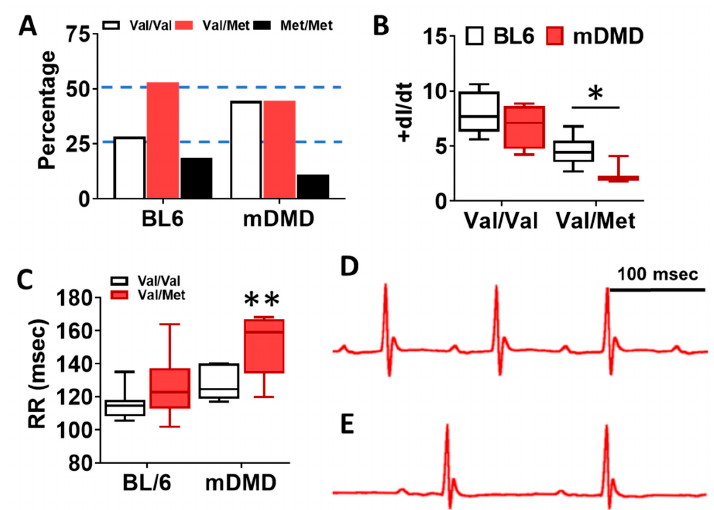
Figure 5. Dystrophic mice have altered distribution of rs6265 polymorphisms, altered cardiomyocyte contractility, and bradycardia. ( A ) Plot showing genotypic distribution of offspring from Val/Met breeding pairs on a normal C57BL/6 (BL6) or mdx/mTR dystrophic (mDMD) background. Percentage of offspring for each of the three possible genotypes are shown on the y axis, with the expected Mendelian ratio of 1:2:1 (or 25%, 50%, 25%) indicated by dashed lines. Val/Val (white), Val/Met (red), and Met/Met (black). ( B ) Box and whisker plot showing peak fractional shortening as the change in the length over time (+dl/dt) of cardiomyocytes isolated from Val/Val or Val/Met mice on a BL6 ( n = 10, n = 14) or mDMD ( n = 4, n = 3) background. ( C ) Plot showing the RR interval as measured by electrocardiography of Val/Val (white) and Val/Met (red) mice on the C57BL/6 (BL6, n = 8, 18) or mdx/mTR (mDMD, n = 6, 3) background. Example electrocardiograms are also shown for Val/Val ( D ) and Val/Met ( E ) mice on the mDMD background. * Asterisk represents statistical significance (* p = 0.0282, Student’s t -test, p = 0.0032, two-way ANOVA), ** p = 0.0025 (two-way ANOVA).